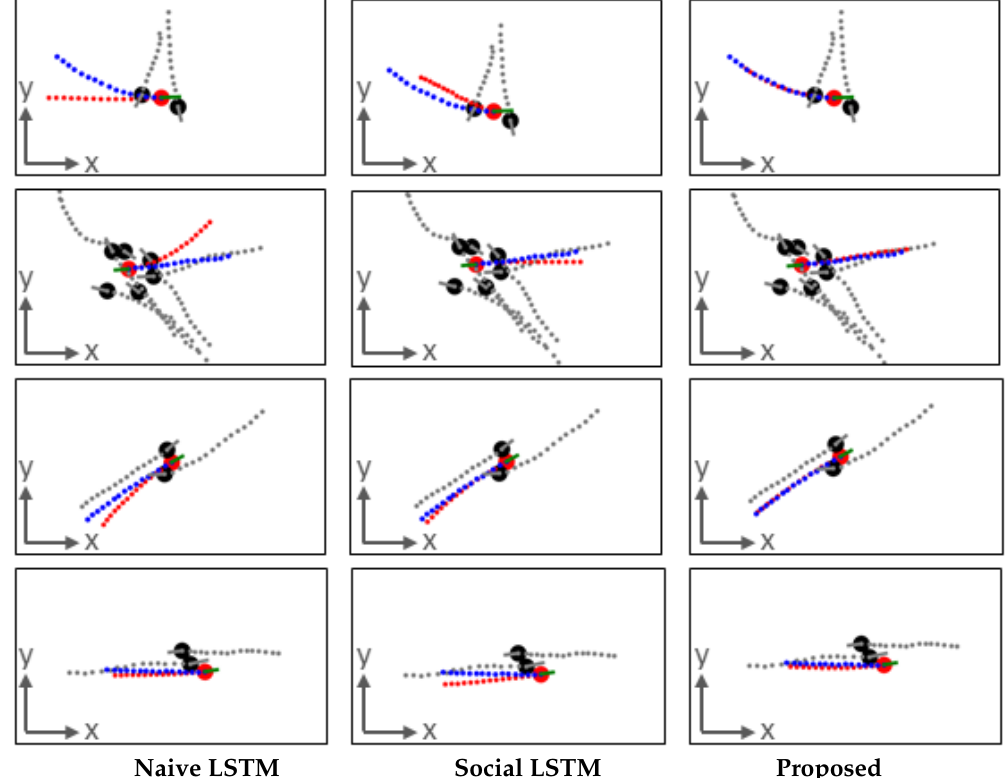
Figure 10. Four examples of trajectory prediction results from 3.2 s observation to 6.0 s prediction. Each row is an example. In every figure, each dot (red: agent, black: neighbors) is a pedestrian. For agent, green solid line: past trajectory, red dashed line: prediction, blue dashed line: ground truth. For neighbors, gray solid line: past trajectory, gray dashed line: following real trajectory. Results of Naive LSTM ( left ); results of Social LSTM ( middle ); results of proposed ( right